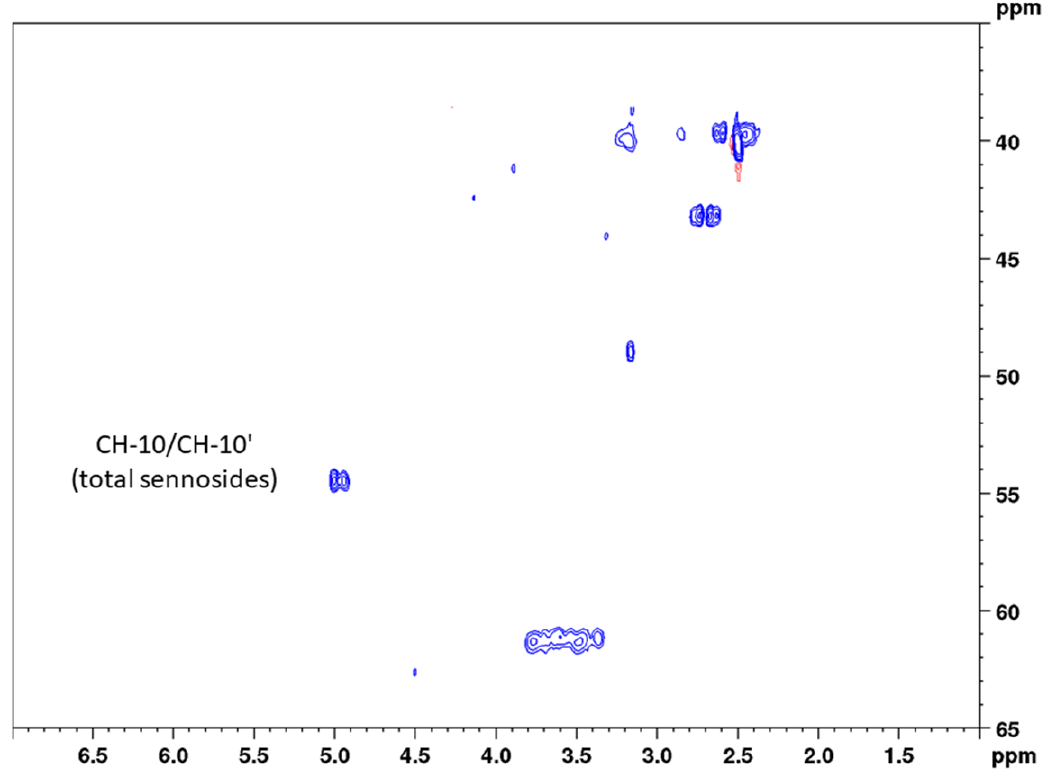
Figure 4. Band-selective HSQC diagram of senna solid-phase extract (1 g pods) in DMSO- d 6 with delays optimized for 138 Hz in the range of 1.0 to 7.0 ppm ( 1 H) and 35 to 65 ppm ( 13 C).